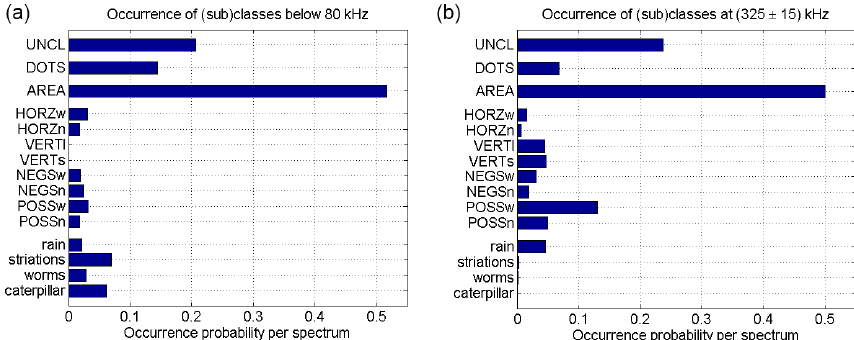
Figure 6. Two bar charts showing the occurrence probabilities per spectrum of various classes/sub-classes of SKR fine structures for lower frequencies (below 80kHz) in (a) and for medium frequencies (around 325kHz) in (b) . The statistics are based on a total number of 5551 SKR 80kHz WBR spectra and on 3973 WBR spectra at 325kHz,